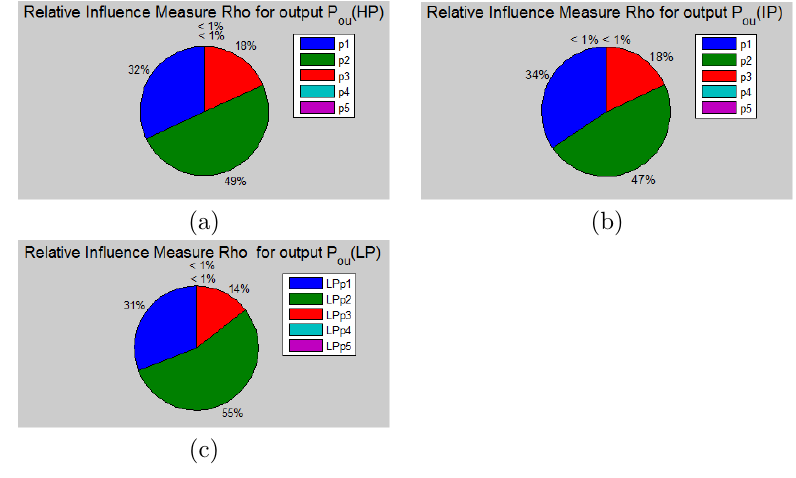
Figure 6. Relative influence measure ρ i for output P ou in (a) high pressure, (b) intermediate pressure and (c) low pressure section of a steam turbine